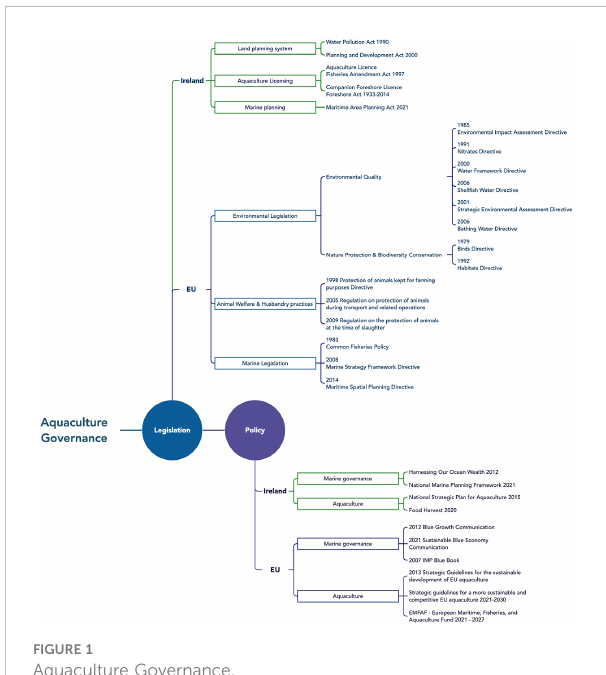
FIGURE 1 Aquaculture